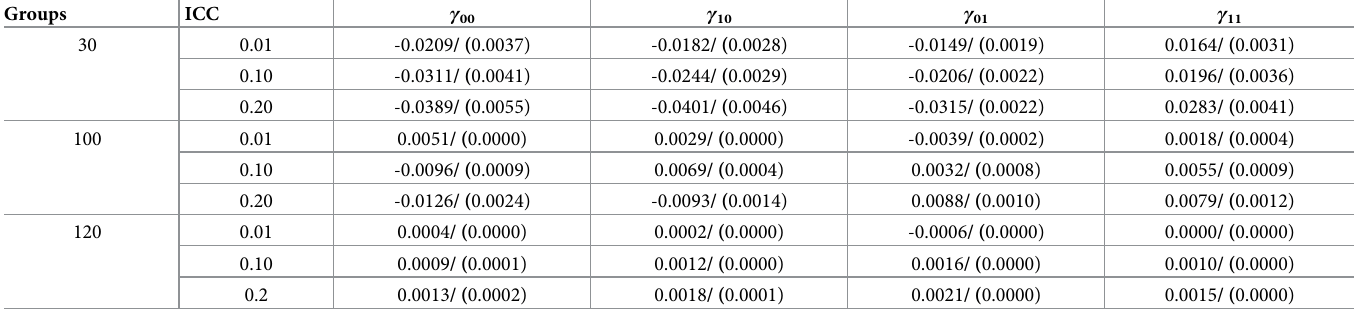
Table 1. Average relative parameter bias of fixed effects estimates obtained for normal distribution data (First = REML estimation procedure, Second = Bootstrap estimates are enclosed in parenthesis). Groups